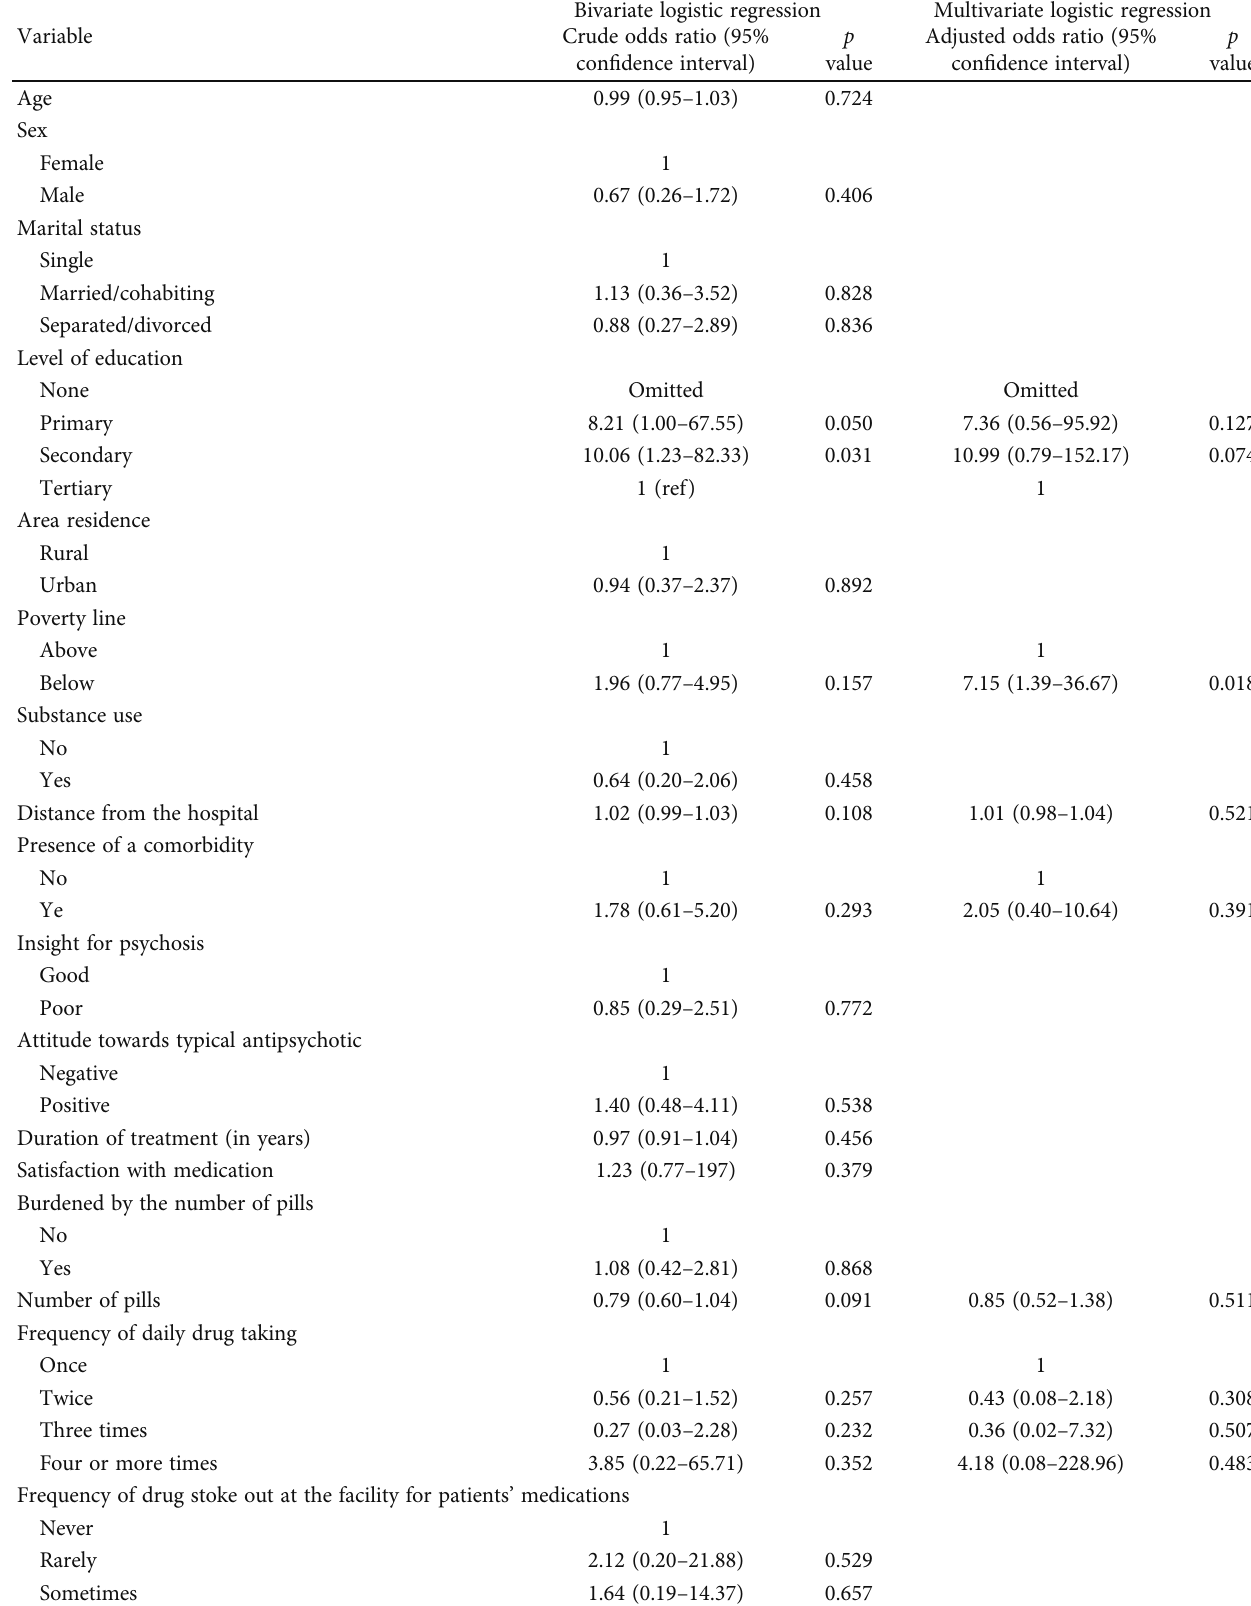
Table 5: Factors associated with nonadherence to typical antipsychotic medications among patients with